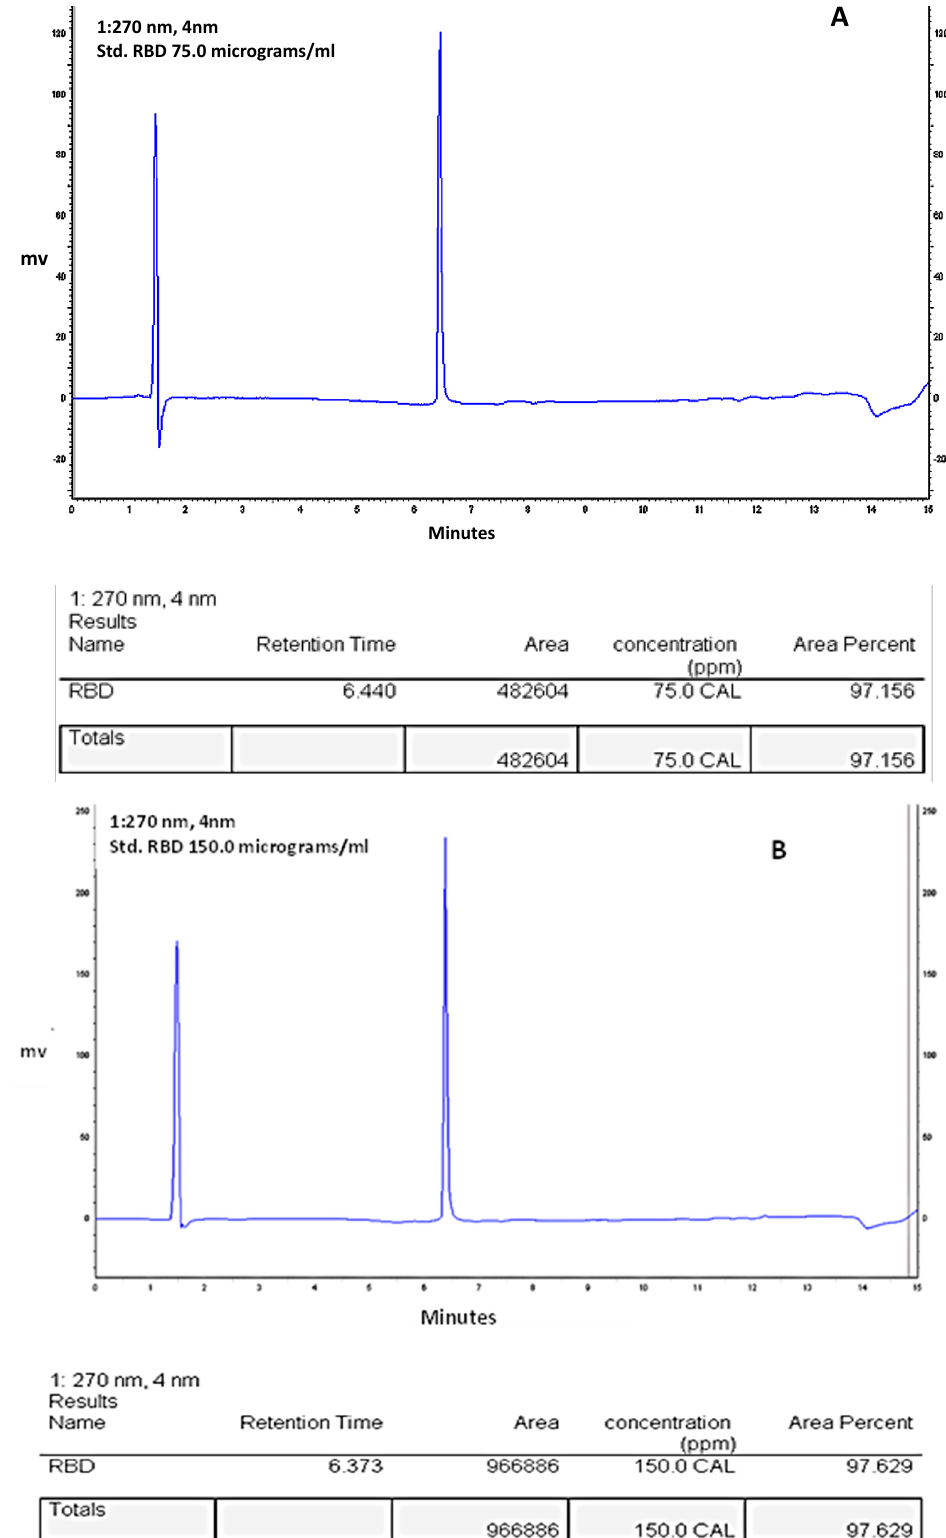
Figure 5. Assessment of purity of C1-cell manufactured RBD-C-tag, as determined by reverse phase HPLC-reverse phase chromatography. The purity of the two different RBD sample runs were 97.16% for the sample with 75 µ g RBD ( A ) and 97.63% for the sample with 150 µ g RBD ( B ). part per million (ppm), Calculated (CAL), millivolts